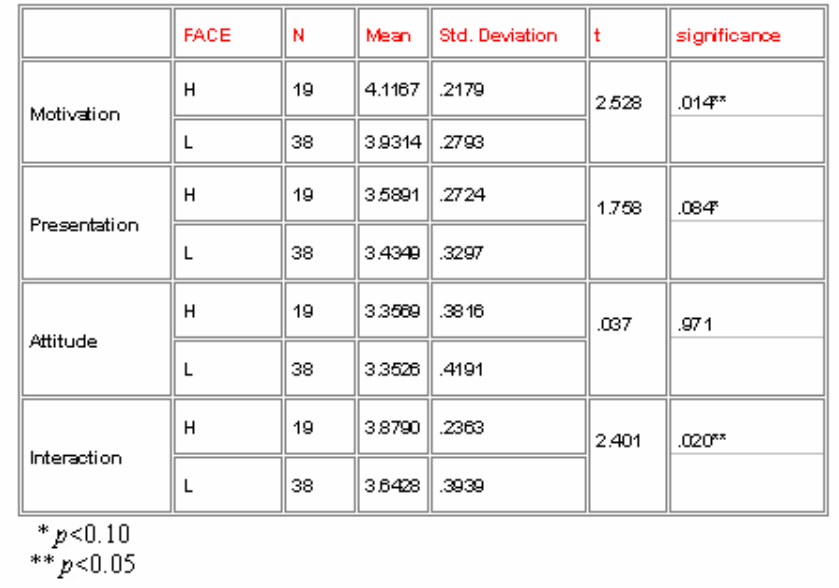
Groups on the Four Teaching